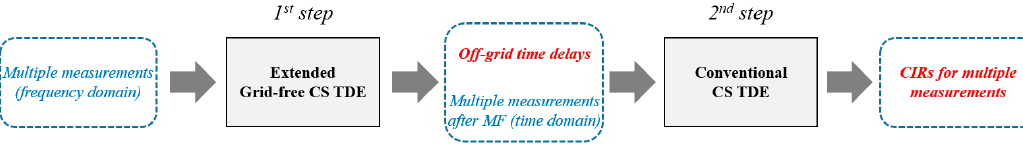
Figure 7. The process of extracting CIR from multiple measurements using the extended grid-free compressive time delay estimation (TDE) with conventional on-grid compressive TDE: Multiple measurements (frequency responses of received signals at a sensor) are used as input for extended grid-free compressive time delay estimation, which estimates time delays of arrivals in continuous time domain. The off-grid time delays from the previous step and matched filter (MF) results are used as input for the second step (conventional on-grid TDE). It evaluates approximated CIRs composed of dominant arrivals along multiple measurements, and their average provides refined CIR at the sensor.